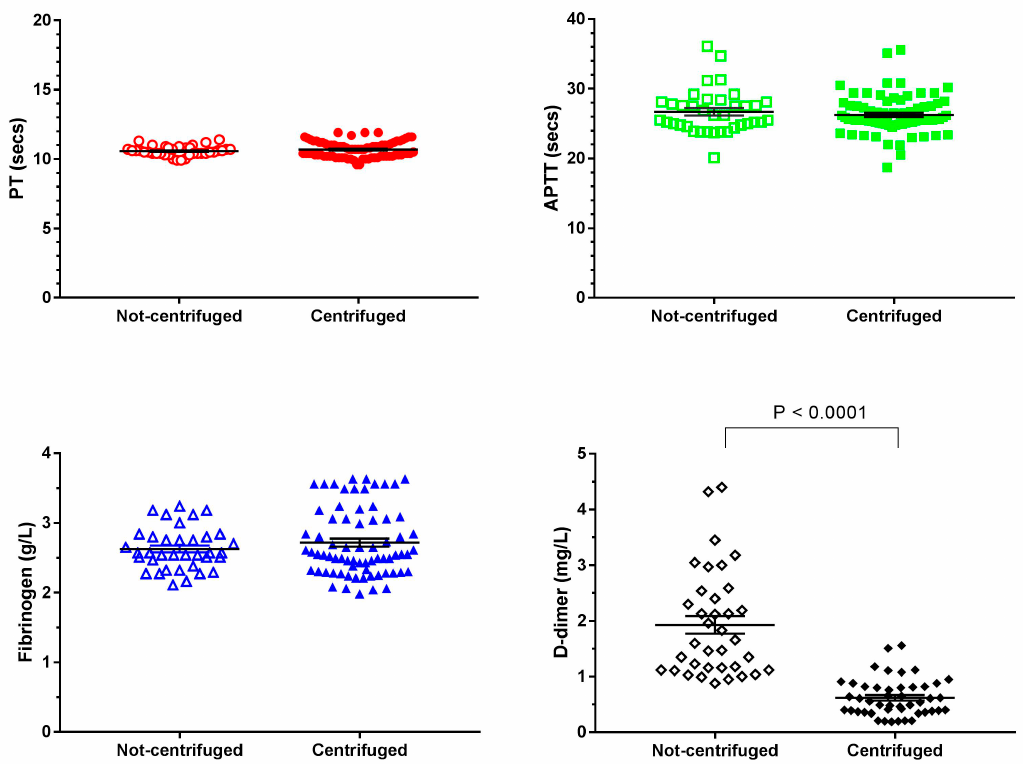
Figure 1. E ff ect of collection method on four haemostatic parameters. Naïve blood samples were collected from healthy UK volunteers and analysed for Prothrombin Time (PT), Activated Partial ThromboplastinTime (APTT), fibrinogen, andD-dimeramounts. Plasmawasobtainedbycentrifugation (standard method) or by non-centrifugation where blood was left to separate over time. Non-centrifuged plasma was collected for comparison with Ebola virus-infected plasma samples collected without centrifugation. Each test was run in duplicate and both values are shown. For some centrifuged samples, multiple aliquots from the same donor were analysed on di ff erent occasions, each individual result is also shown. Mean and SEM (coloured lines and bars) are shown for each data set. Unpaired t -tests were performed to compare the results from the two collection